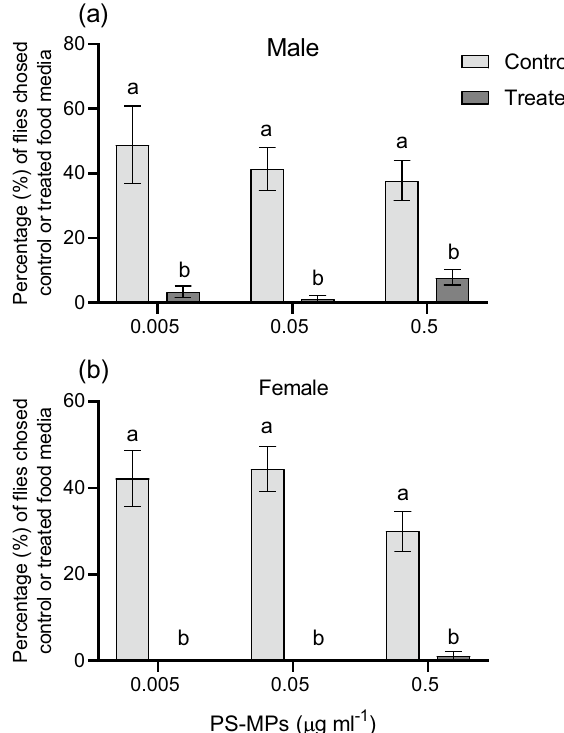
Figure 1. Percentage (%) (mean ± standard error mean (SEM)) of ( a ) male and ( b ) female flies (n = 10) chose control or food media treated with different concentrations of polystyrene microplastics (PS-MPs). Flies were free to move around and choose their preferred food before being counted every 5 min for 30 min as they stood and attempted to feed on each food. Flies were able to discriminate between control and PS-MPs treated food media regardless of the concentrations of PS-MPs and chased non-treated food media. Different lower-case letters denote a significant difference between treatments (student t -test, P <